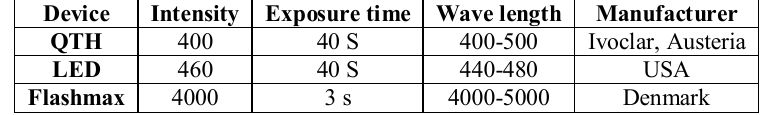
Table 2: curing systems used in this study